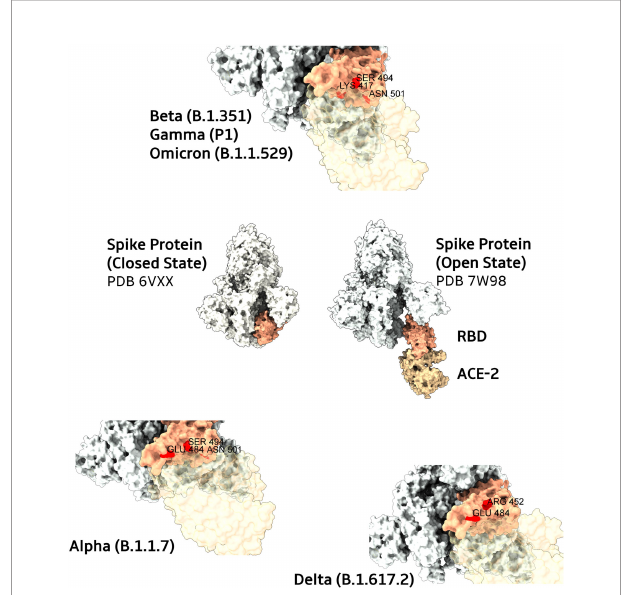
FIGURE 2 | Main mutations present in SARS-CoV-2 Spike protein variants. In the center, structures from Spike proteins (colored in ivory) in their closed and open states (complexed with ACE2, in light brown). The RBD domain is highlighted in salmon. Closes from the ACE2 interaction interfaces of RBD domains are depicted for Beta, Gamma, and Omicron (top), Alpha (bottom left), and Delta (bottom right) variants. Mutated residues are colored in red with their respective name and positions. To improve the visualization of variants mutated regions, transparency was applied to ACE2 protein surfaces.